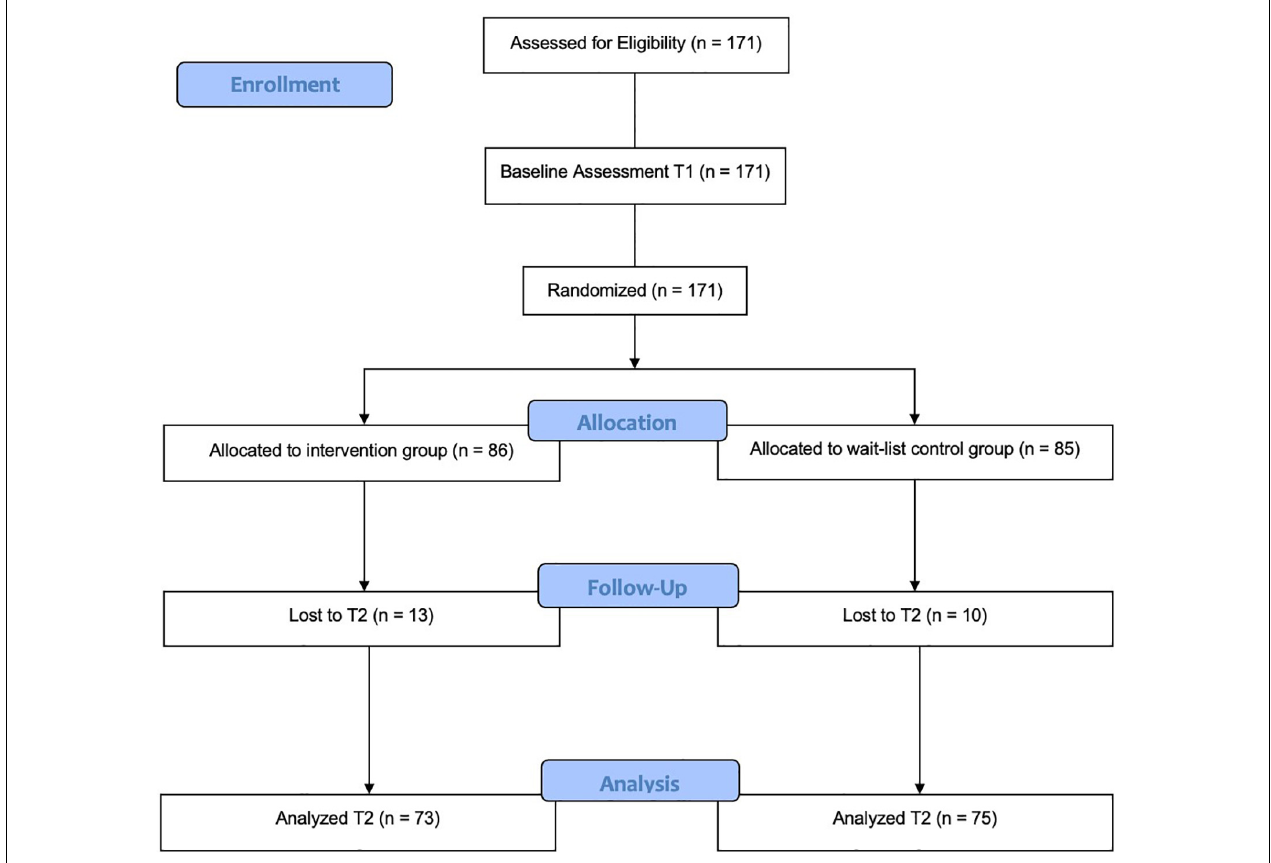
FIGURE 1 | CONSORT flow